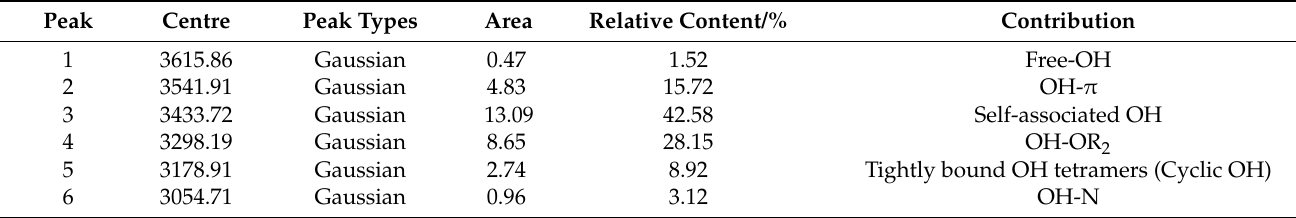
Table 9. Aliphatic hydrocarbon parameters of Kerjian coal.